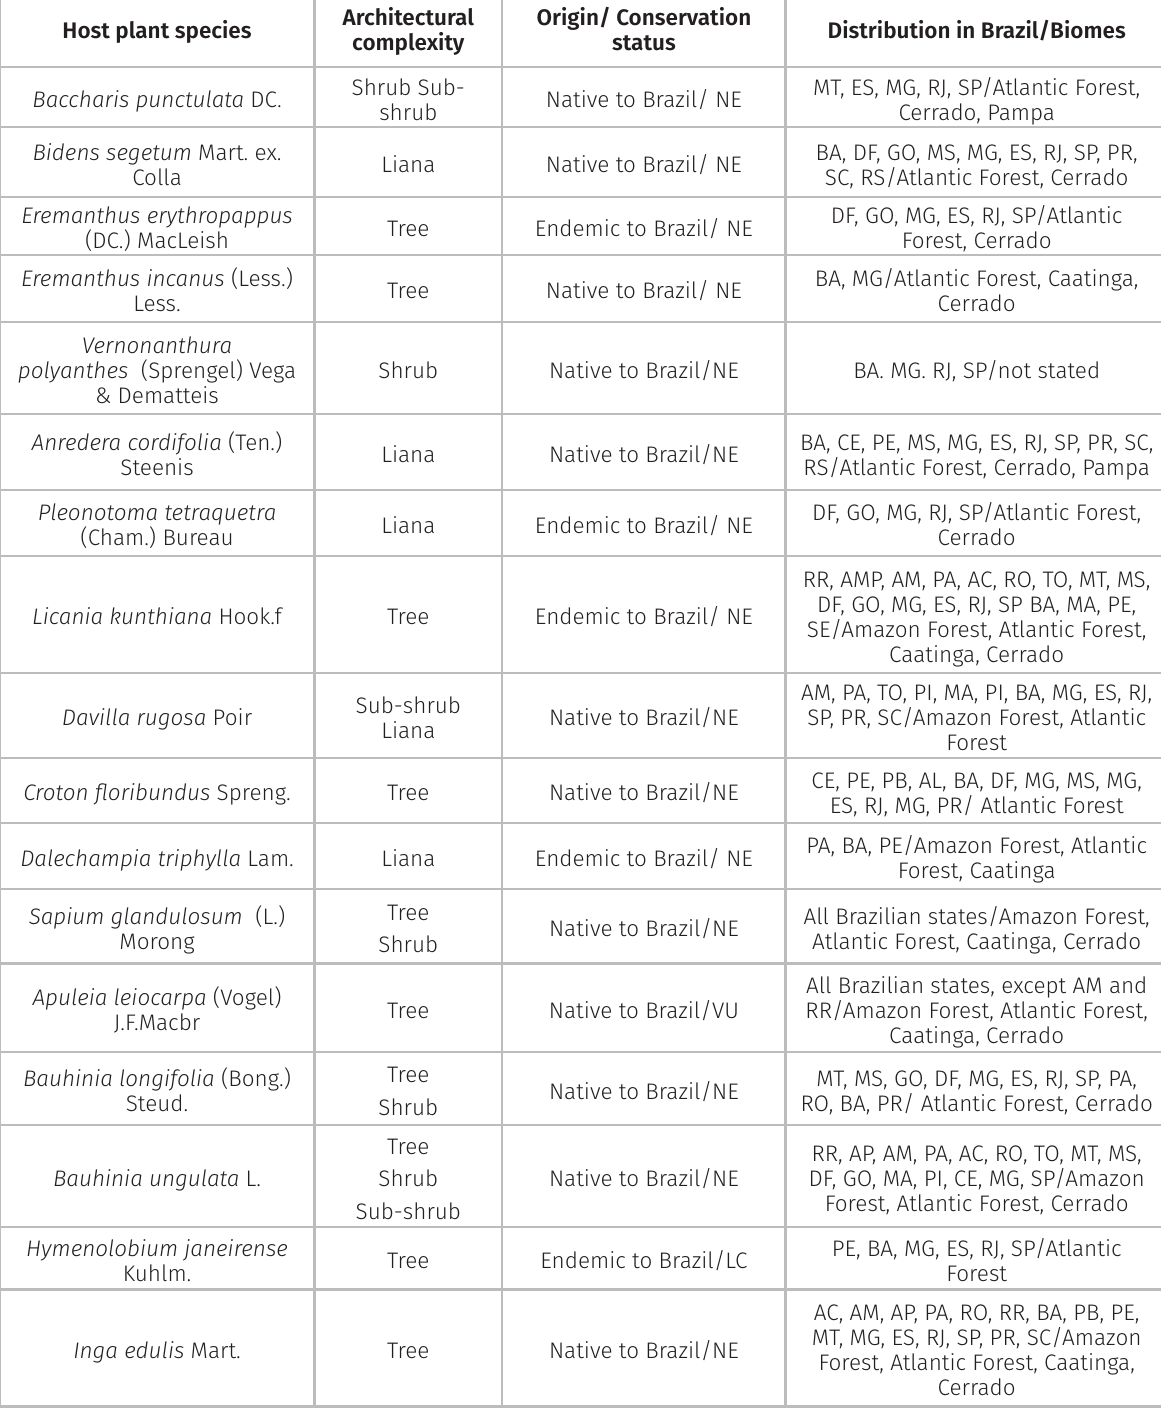
Table VI. Data on host plant species: architectural complexity, origin, conservation status and distribution in Brazil (states and